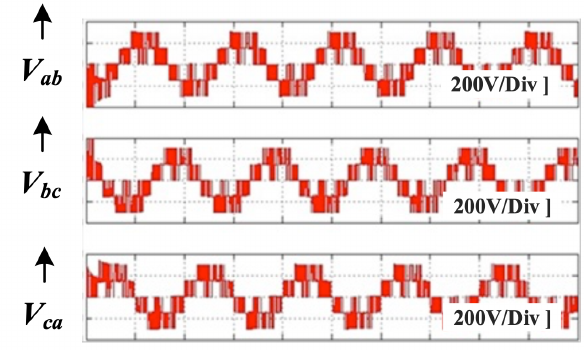
Fig. 5. Simulation results a. V line [ 200V/div ] [ 2ms/div ]